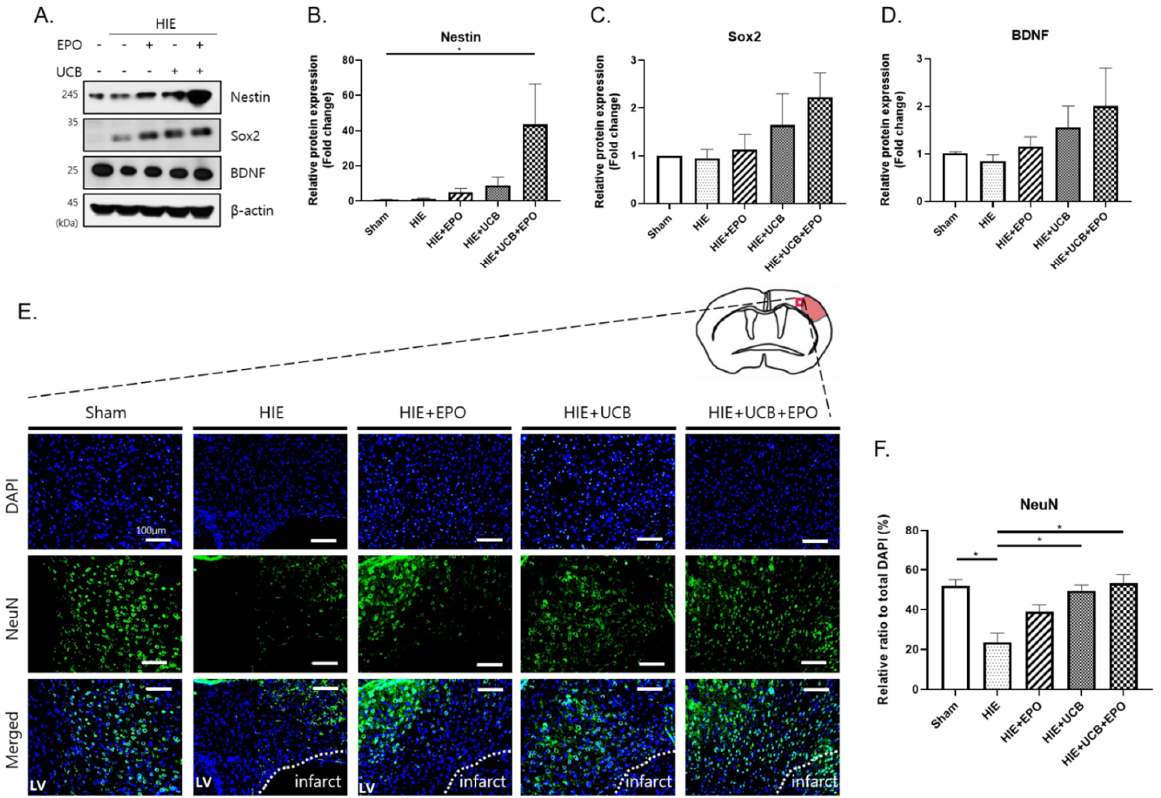
Figure 6. Neuroregenerative capability by the combination treatment hUCB and rhEPO group was increased in the HIE model through a synergistic effect. ( A ) Up-regulation of the levels of Nestin, Sox2, and pro-BDNF (32 kDa) protein was shown by Western blot. ( B – D ) The graphs depict band intensity. ( E ) Neuroprotection was observed through immunohistochemistry staining for NeuN in the peri-infarct cortex of the HIE brain. White bar indicates 100 µm. ( F ) The graph depicts the quantification of the number of NeuN (+cells. Data shown as the mean ± standard error of mean. n = 3 per group. * p < 0.05 (( B , D ) Kruskal–Wallis; ( C , F ) one-way ANOVA).